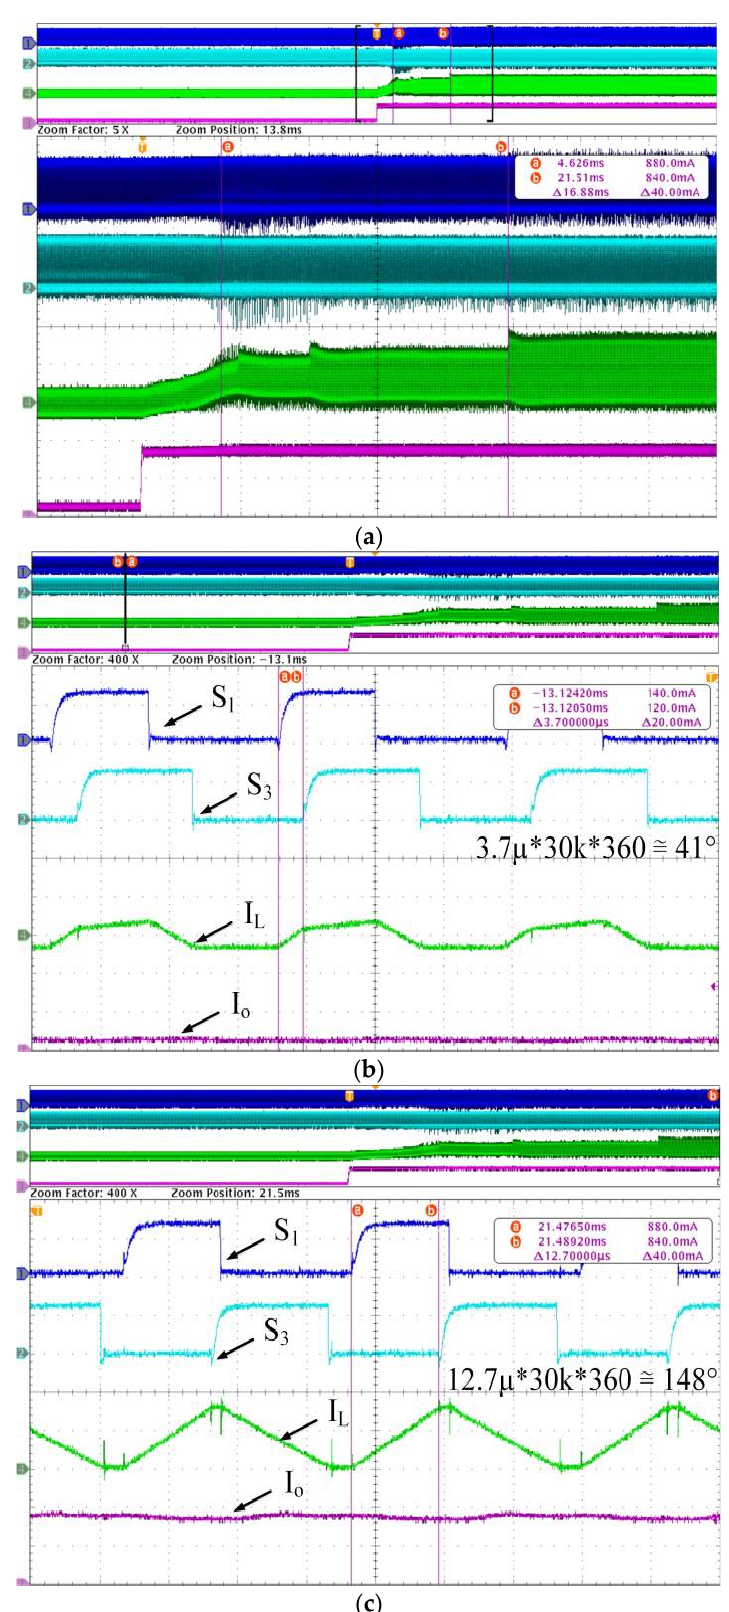
Figure 20. Measured waveforms of the proposed APS control method during a load change (50 W to 300 W). ( a ) Full view; ( b ) Enlarged view at 50 W (41°); ( c ) Enlarged view at 300 W (148°). (CH1: 10 V/div, CH2: 10 V/div, CH4: 2 A/div)